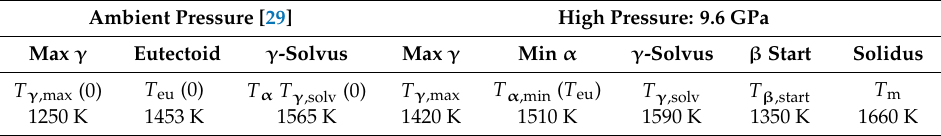
Table 2. Transition and other distinct temperatures. Ambient pressure values after